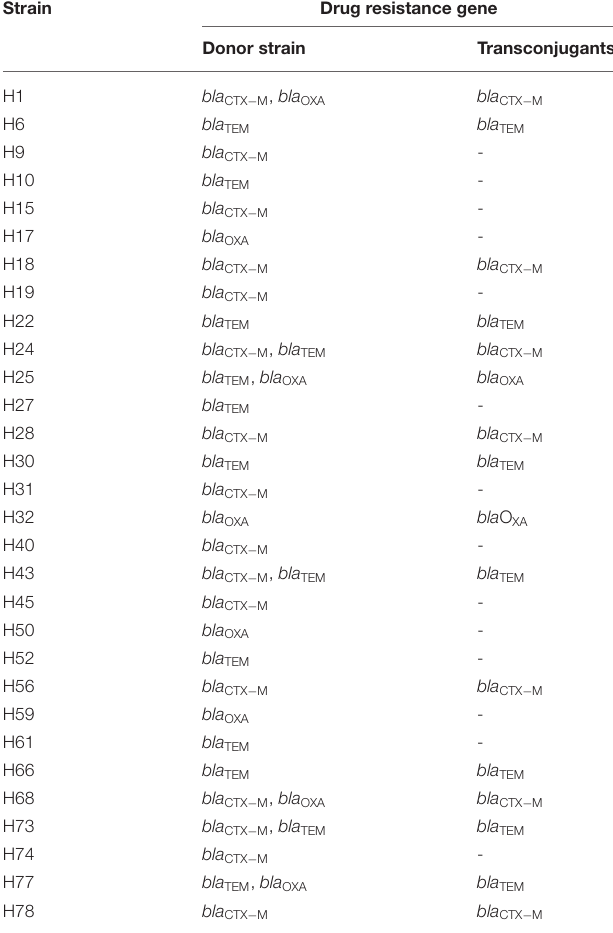
TABLE 8 | ESBLs-encoding genes carried by donor isolates and